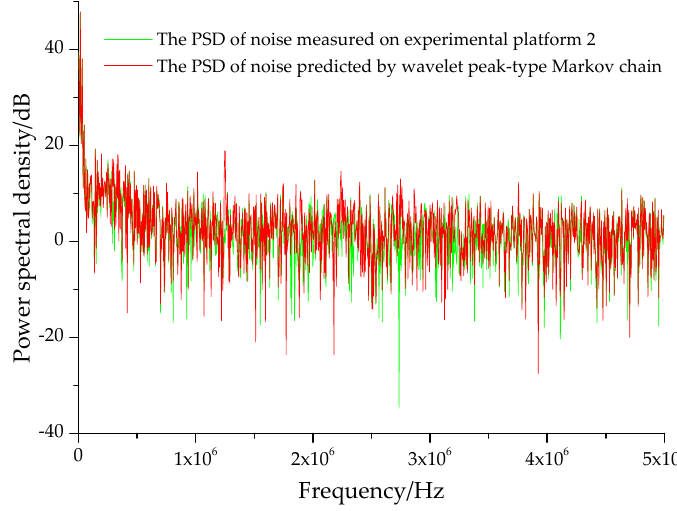
Figure 16. The power spectral density (PSD) of measured noise before and after modeling.